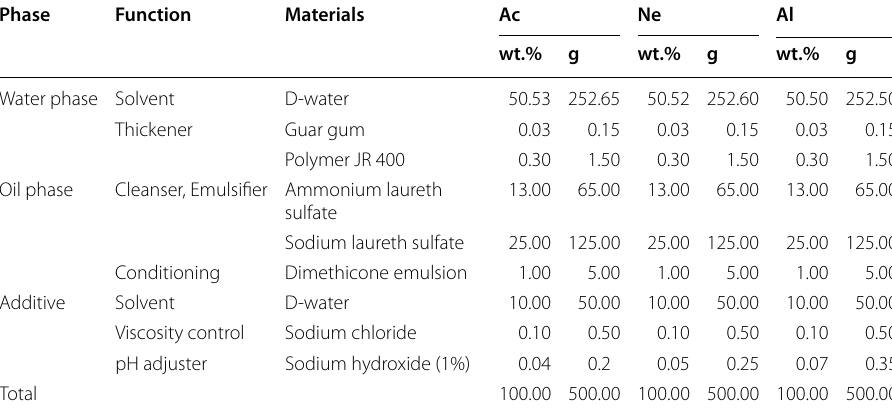
Table 2 Formulation of three types of